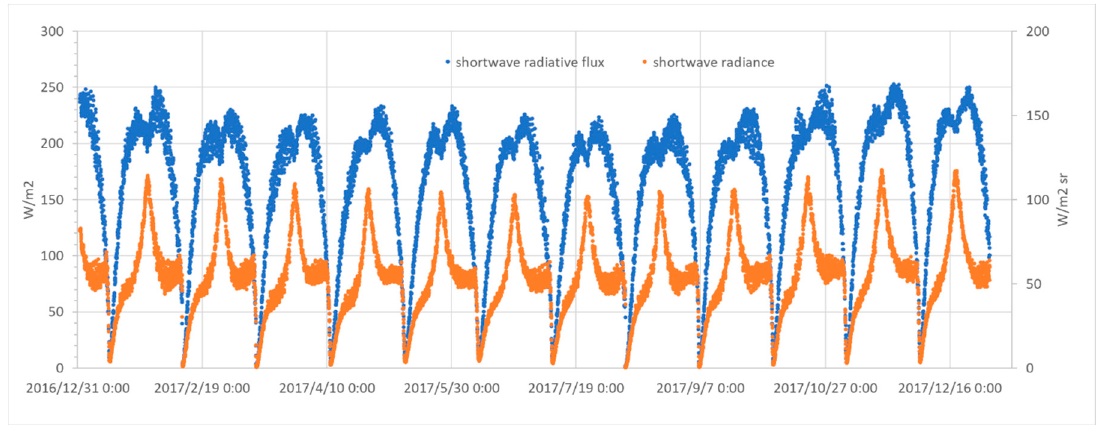
Figure 6. The time series of simulated global mean OSR flux and the global mean shortwave radiance in the Moon-based view, in 2017.